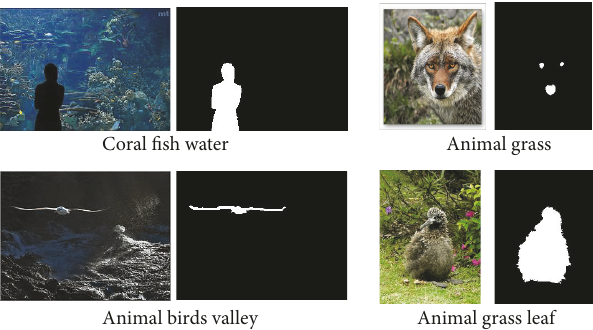
Figure 9: Images with cluttered and complex backgrounds.